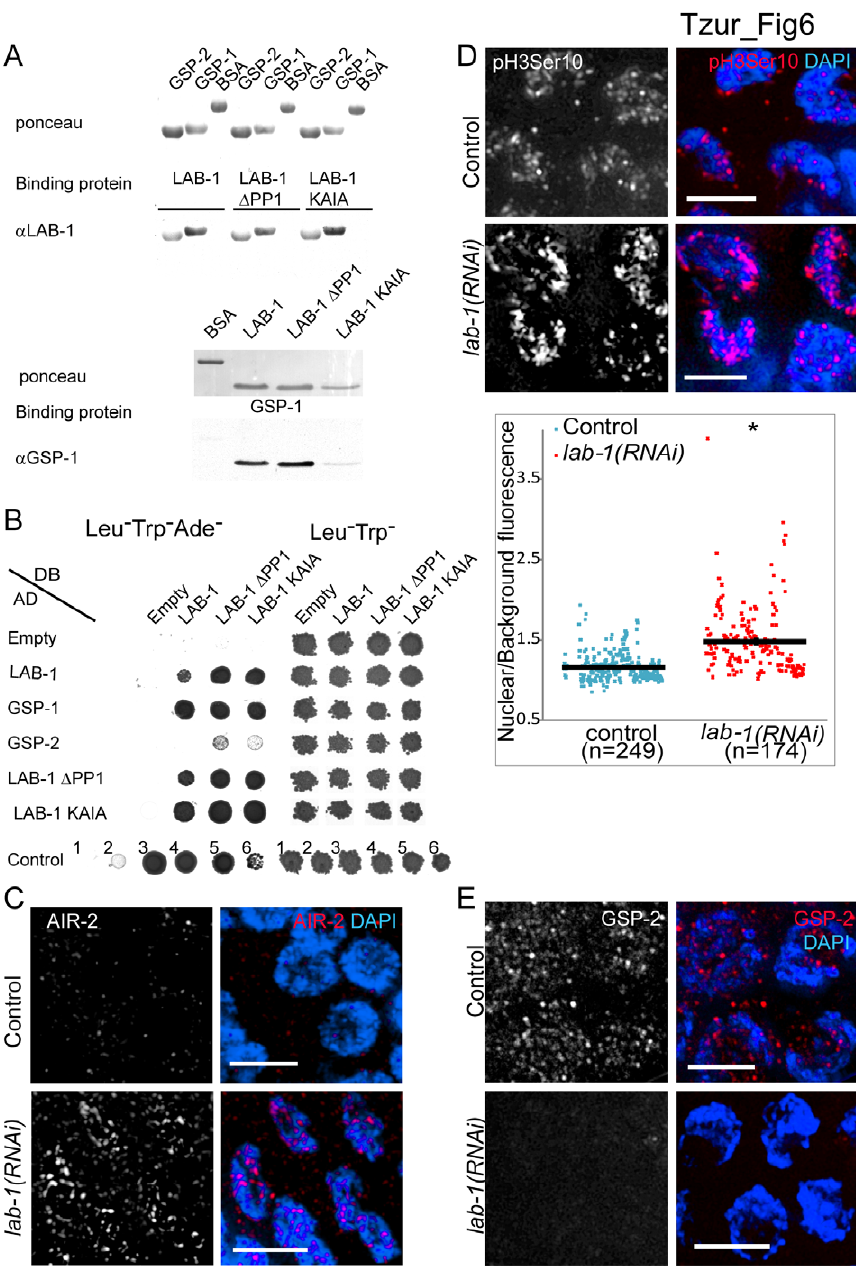
Figure 6. LAB-1 binds GSP-1 and GSP-2 and is required for correct AIR-2 and GSP-2 localization on early meiotic nuclei. (A) Far- western analysis of in vitro binding of purified recombinant LAB-1, LAB-1 PP1 putative motif mutants, GSP-1, and GSP-2. Purified bacterially expressed proteins were transferred to membranes, incubated with the indicated binding protein, and probed with appropriate antibodies. BSA was used as control. (B) The yeast two-hybrid system was used to test the protein interactions between LAB-1, LAB-1 PP1 putative motif mutants, GSP-1, and GSP- 2. Proteins were fused to either the DNA binding domain (DB) or the activation domain (AD) of GAL4. Interactions were scored by growth on SC-Leu- Trp-Ade plates. Growth on SC-Leu-Trp was used as a control. Negative (No. 1) and positive (No. 2–6) controls are shown. Positive interactions are shaded in gray. (C) Transition zone nuclei in control and lab-1(RNAi) gonads co-stained with AIR-2 (red) and DAPI (blue). (D) Transition zone nuclei in control and lab-1(RNAi) gonads co-stained with H3S10ph (red) and DAPI (blue). A quantification plot is presented below where each dot represents the ratio between the level of fluorescence detected for an individual nucleus and that of the adjacent background. Error bars represent standard deviation of the mean. Asterisk indicates statistically significant increase in fluorescence ( p , 0.0001, by the two-tailed Mann-Whitney test, 95% C.I.). (E) Transition zone nuclei in control and lab-1(RNAi) gonads co-stained with GSP-2 (red) and DAPI (blue). Bars, 4 m M. mutant LAB-1 proteins could bind GSP-1 (Figure 6A). Thus, the putative PP1 binding motif is probably not necessary for LAB-1 binding to GSP-1 and GSP-2.